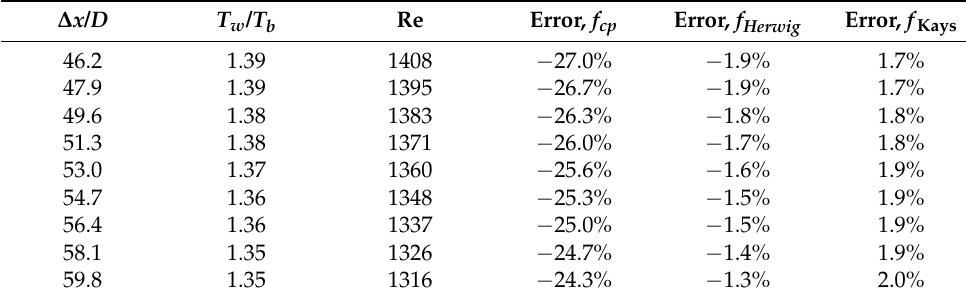
Table 5. Calculation errors of nitrogen by laminar flow f correlations.